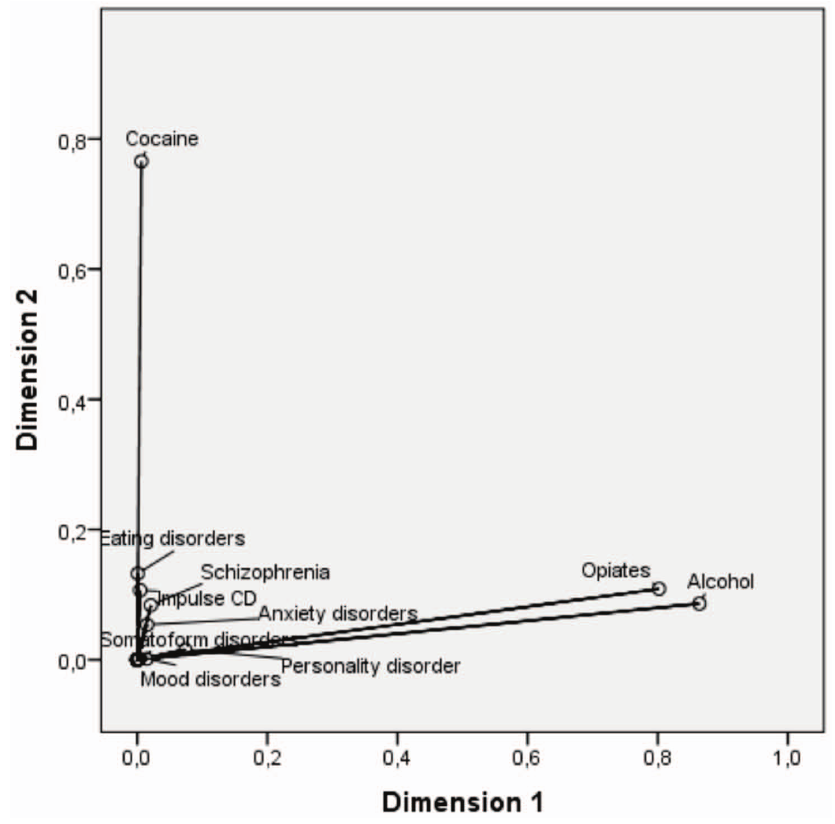
Figure 1. Multiple correspondence analysis of mental disorders and substance abuse.